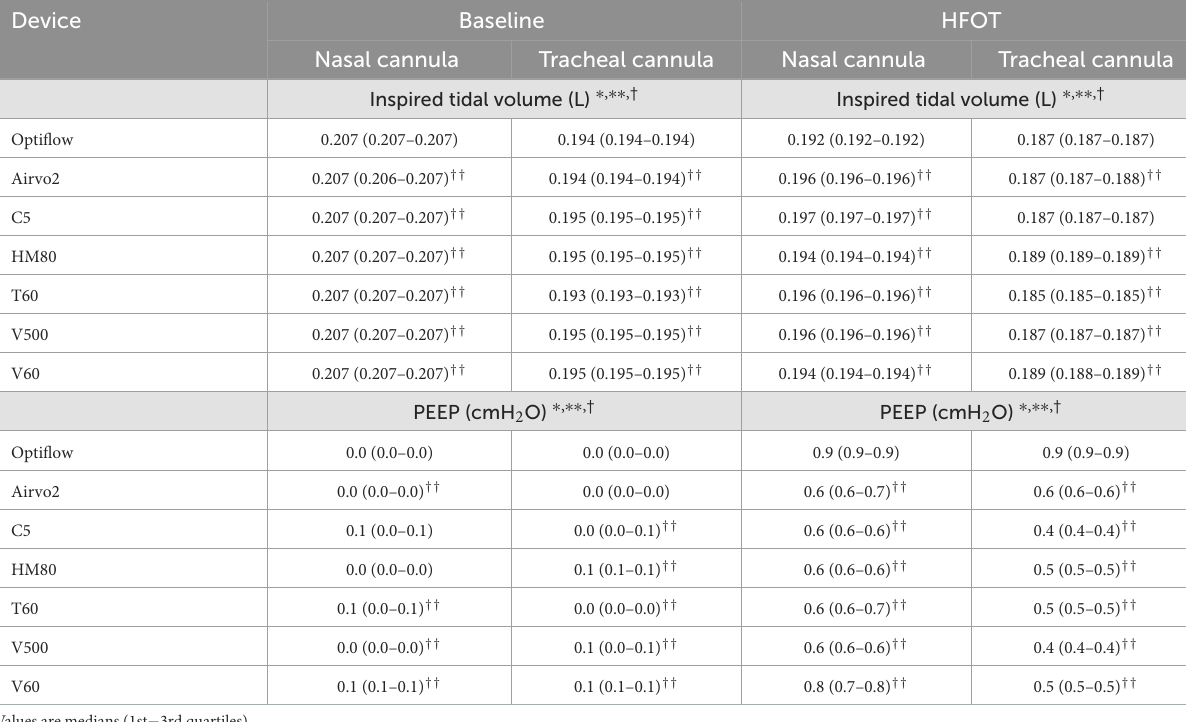
TABLE 2 Inspired tidal volume and positive end-expiratory pressure across devices and cannulas at baseline and under high flow oxygen therapy.